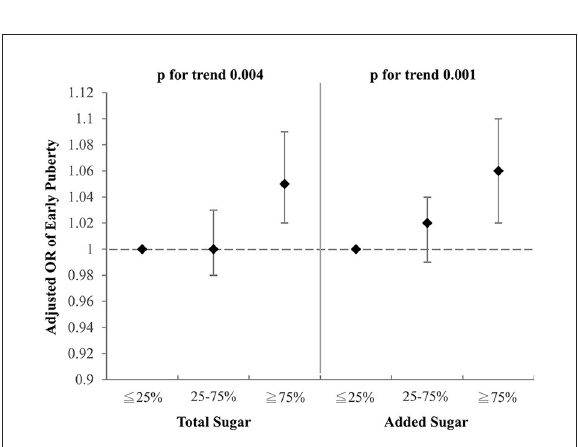
FIGURE3 Adjusted OR for early puberty due to the consumption of total sugar and added sugar from selected drinks (girls). Models were adjusted for BMI, parental educational level, family income, and household